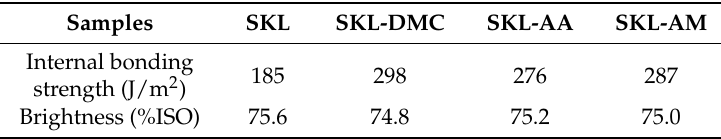
Table 3. Internal bonding strength and brightness of papers.